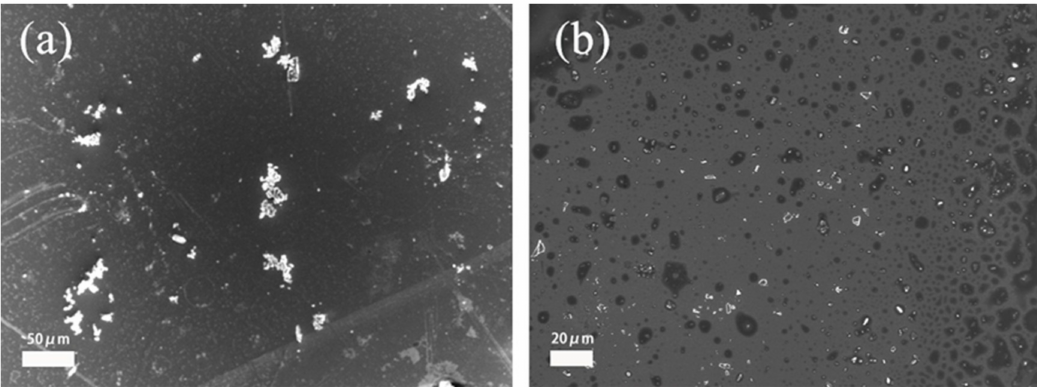
Figure 10. SEM plots of ( a ) MnO 2 @h-BNNs without Span80 and ( b ) MnO 2 @h-BNNs with Span80 dispersion at a content of 0.1%.